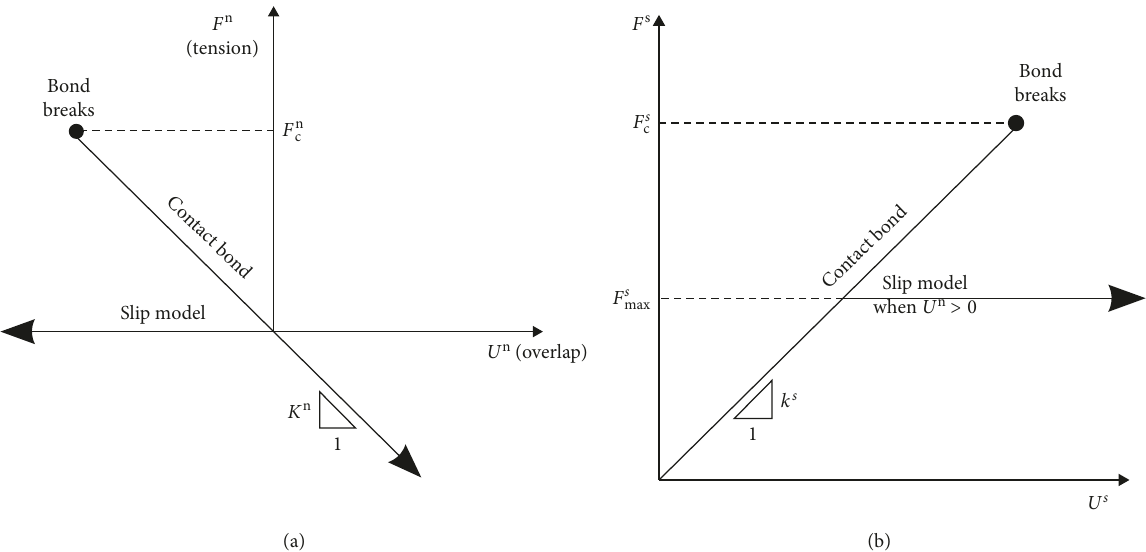
Figure 3: Constitutive behavior for contact occurring at a point. (a) Normal component and (b) shear component of contact force.